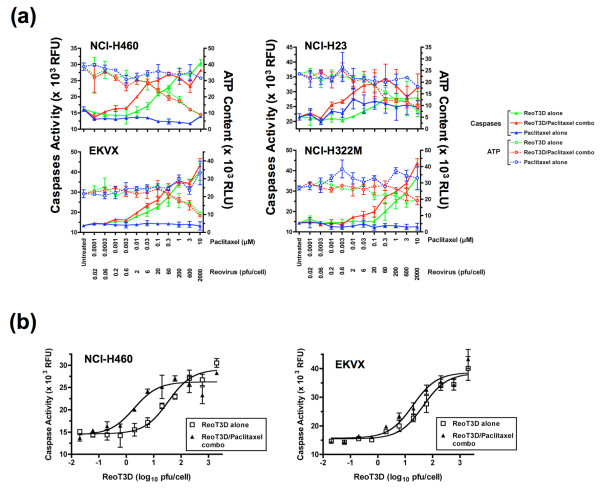
(a) Levels of caspase activity and ATP content in NCI-H460, NCI-H23, EKVX and NCI-H322M cells treated with increasing doses of either ReoT3D or paclitaxel alone, or both in combination for 24 hours, using the constant ratio combination design [15]. This design format was employed to evaluate the synergistic activity of ReoT3D-chemotherapeutic combination regimens (see text). Shown are the mean ± SD in relative fluorescence units (RFU) and relative luminescence units (RLU) for caspase activity (closed triangle) and ATP content (open circle), respectively, for ReoT3D alone (green), ReoT3D-paclitaxel combination (red) and paclitaxel alone (blue). The data shown are representative of 3 separate experiments. (b) Dose-response curves of caspase activation induced by treatment with ReoT3D alone or ReoT3D-paclitaxel combination for 24 hours fitted by non-linear regression using GraphPad Prism (GraphPad Software, Inc.). Shown as an example are non-linear regression analyses for NCI-H460 and EKVX. See text for statistical analysis on the best-fit values.